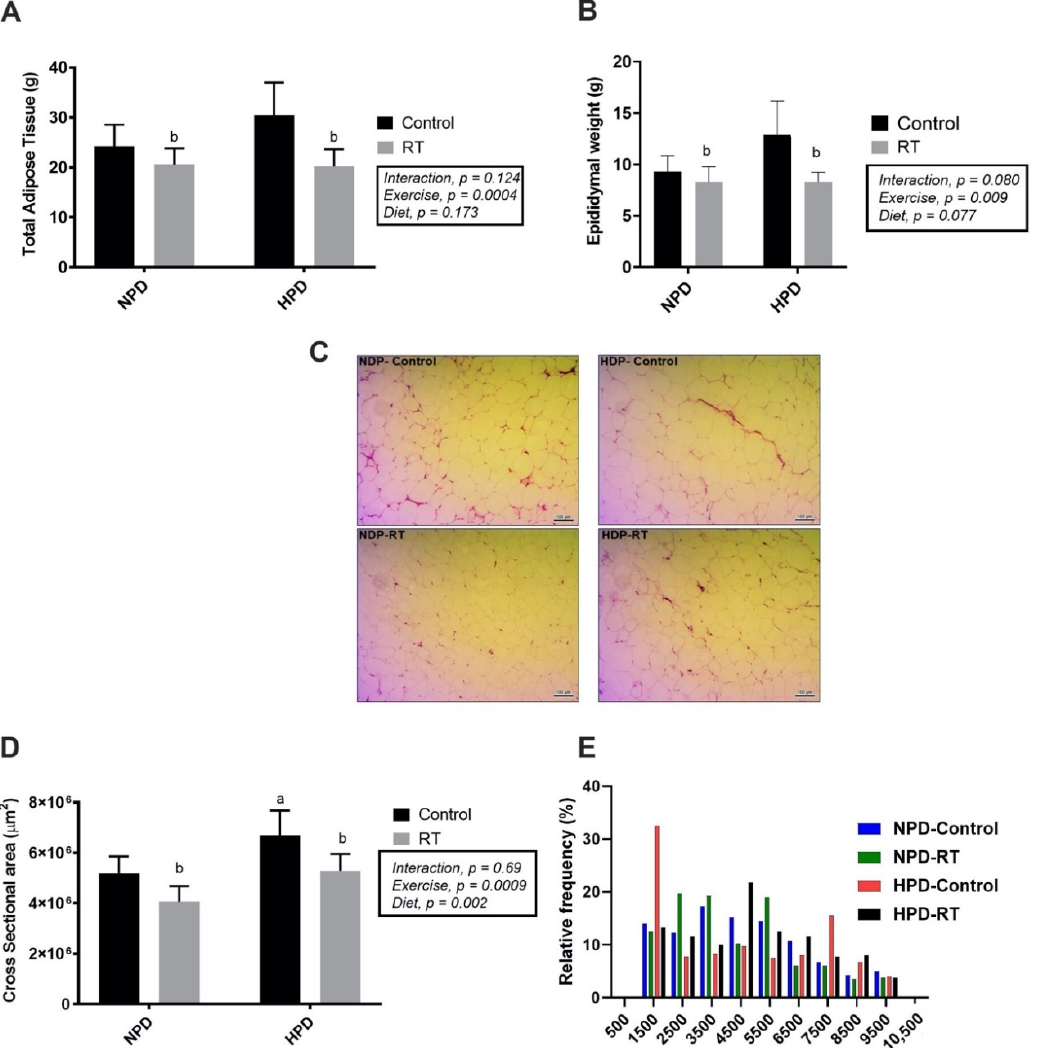
Figure 3. Adipose tissue weight and adipocyte size. ( A ) Total visceral adipose tissue weight; ( B ) epidydimal adipose tissue weight; ( C ) histological sections of the epidydimal adipose tissue post-operation hematoxylin-eosin staining; ( D ) cross-sectional area of epidydimal adipocytes; ( E ) histogram of frequency distribution adipocyte size. Values are presented as means ± SD. a p < 0.05 vs. NPD-Control, b p < 0.05 vs.